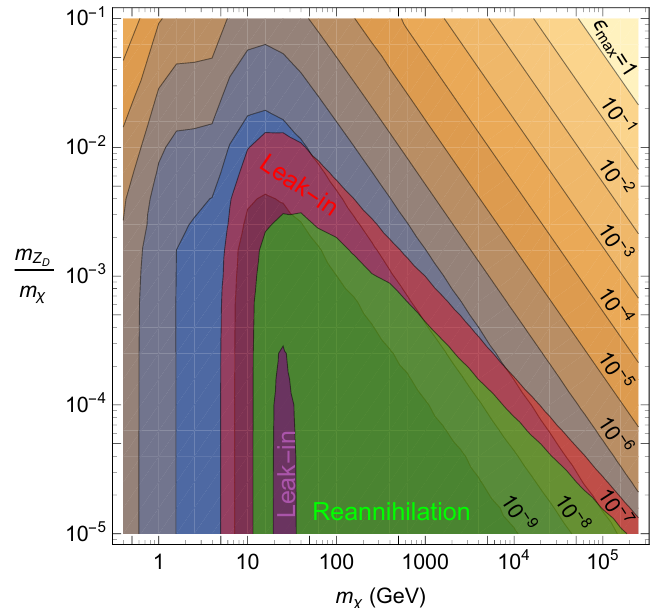
=m (cid:31) vs m (cid:31) . For D